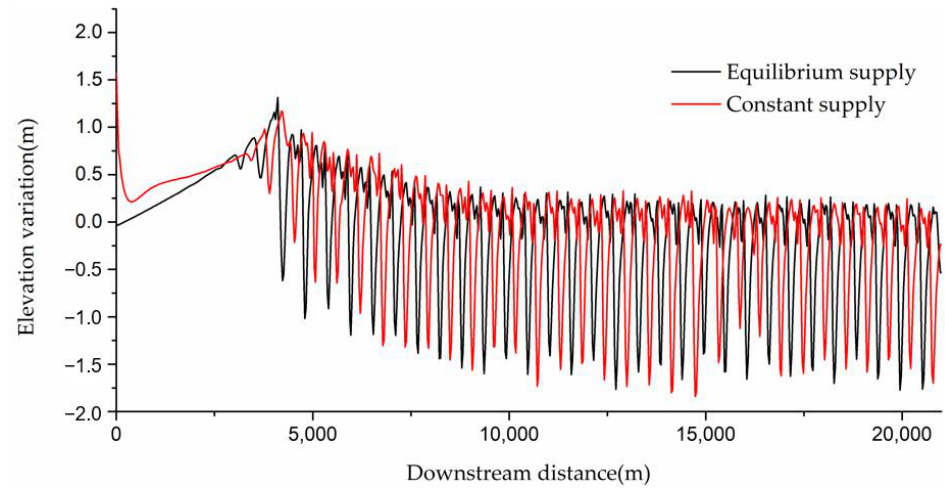
Figure 4. Elevation variation comparison at the right bank in both runs after 25 hydrographs.